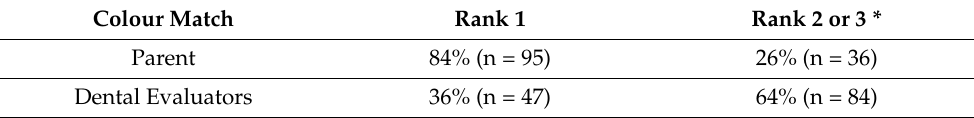
Table 3. Colour match rank by parents and dental evaluators.